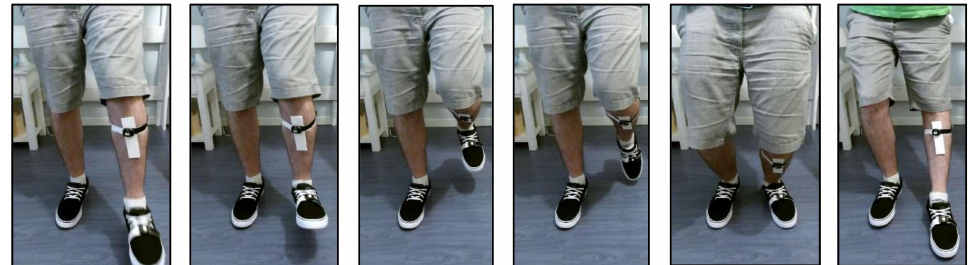
Figure 1. Example of frames from a recording of the Kinect v2 measuring simultaneously with the inertial measurement units (IMUs), one on the foot and one on the leg below the knee, for the calculation of the ankle angle. Distance of 0.5 m. Only shows the region of interest for each